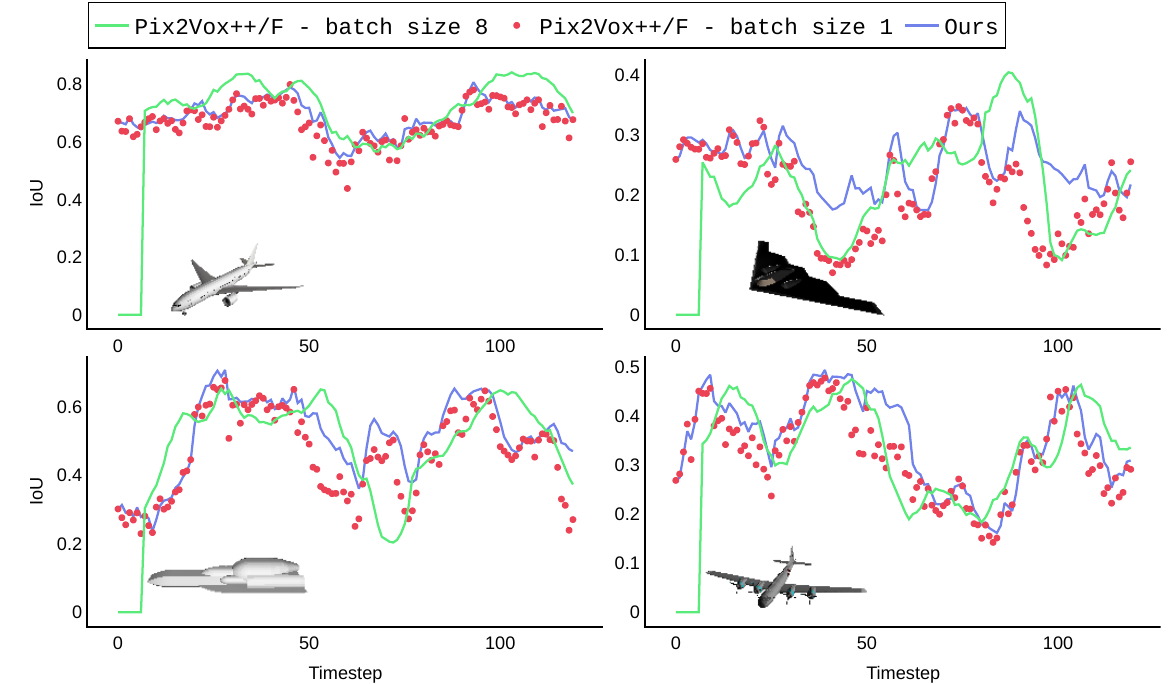
Figure 6. Reconstruction quality fluctuates significantly when processing all 120 images of the extended dataset in order of increasing azimuth. These fluctuations can be attributed for Pix2Vox++/F to the lack of diversity in the input batch, and for our iterative algorithm to long-term memory loss.